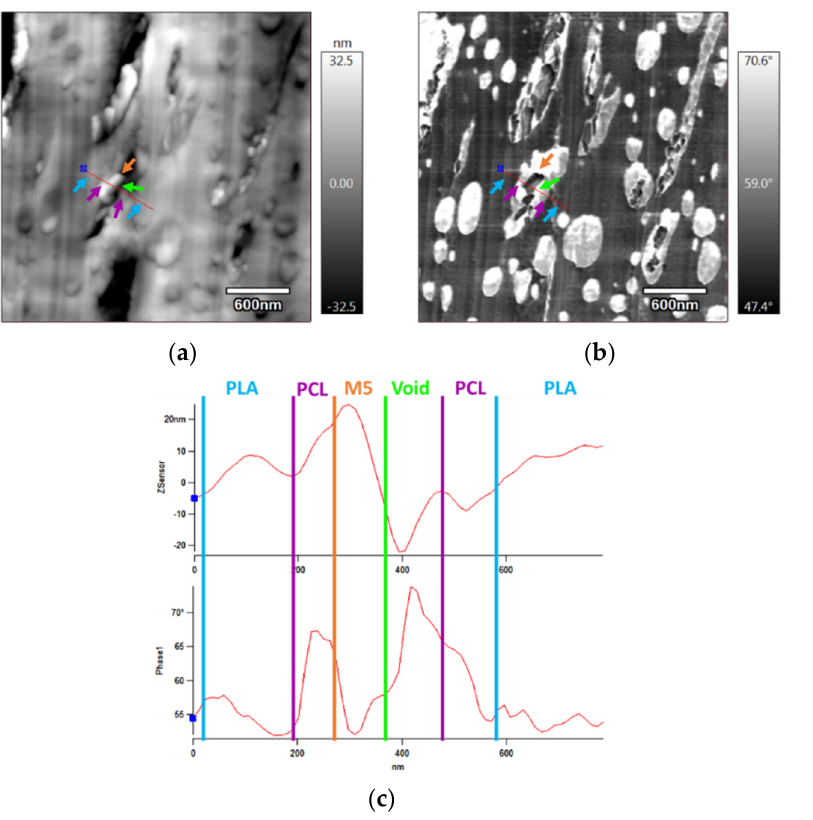
Figure 4. (a ) AFM topography; ( b ) AFM phase images of the PLA/PCL/10 wt.% M5 injection- moulded sample; ( c ) topography and phase profiles on a drawn red line that is traced in ( a , b ) (the fleshes in the images point towards the different components of the composite and their colours match the designation of the peaks in the profiles).